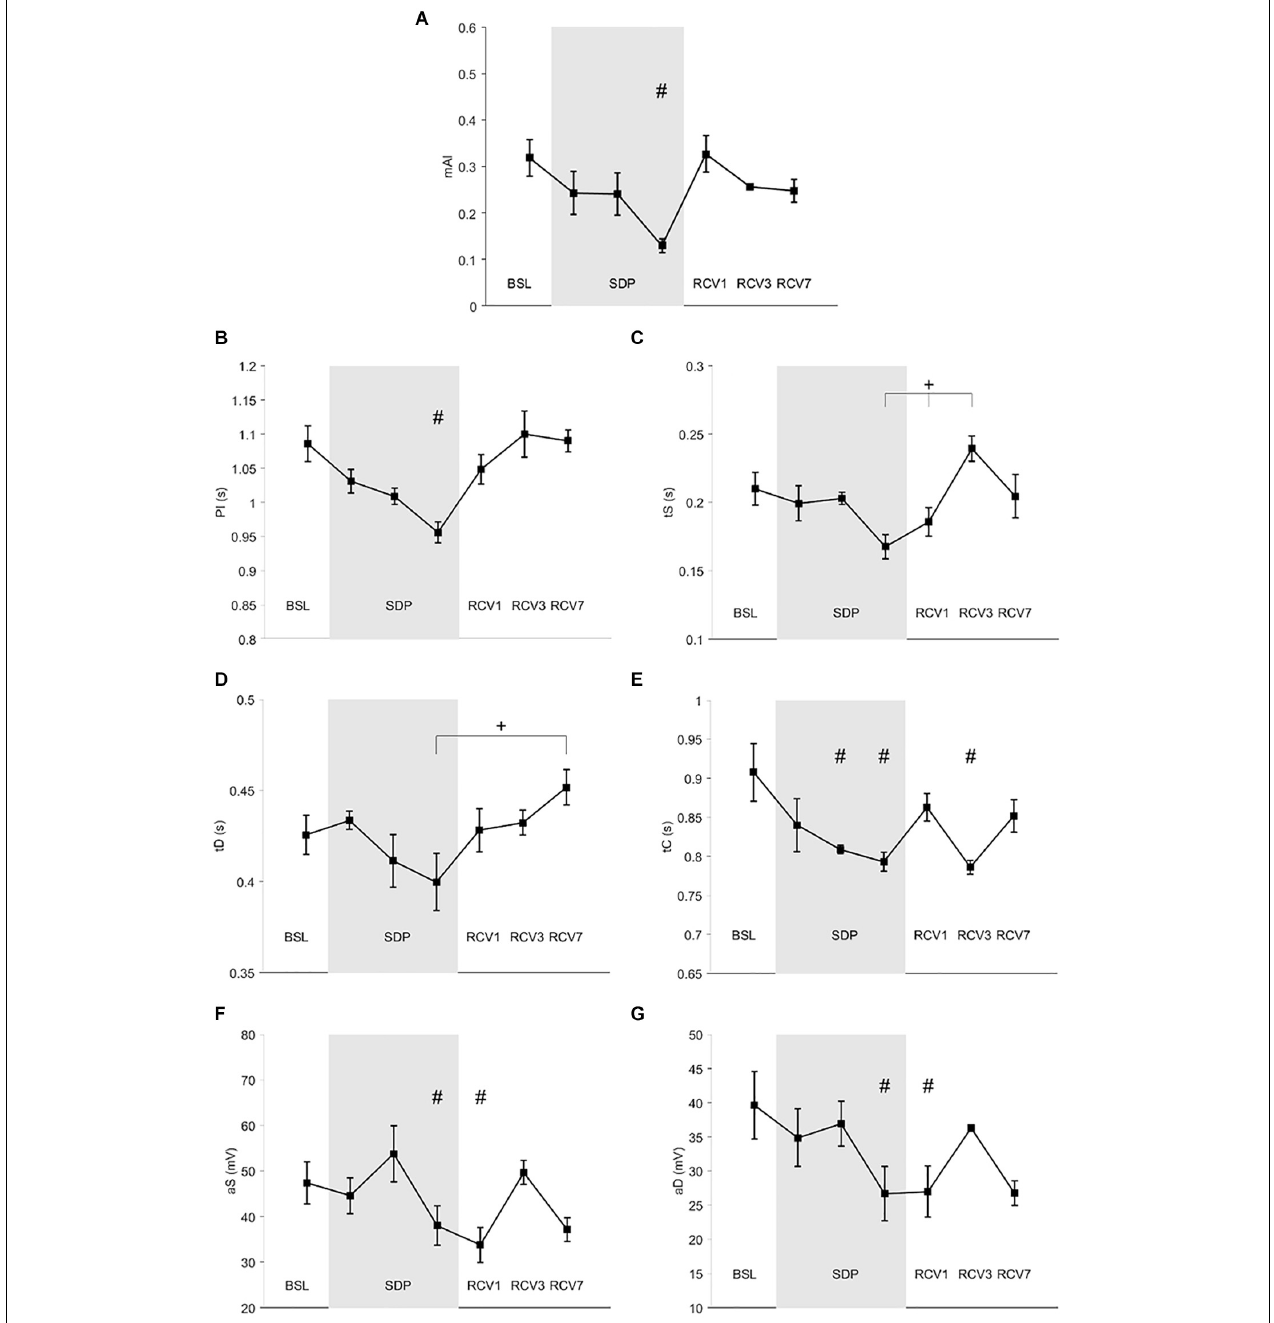
FIGURE 3 | Photoplethysmography (PPG) parameters during baseline (BSL), sleep deprivation (SDP), and recovery (RCV) periods. (A) mAI, modified augmentation index; (B) PI, pulse interval; (C) tS, time of systolic wave; (D) tD, time of dicrotic wave; (E) tC, time of catacrotic wave; (F) aS, systolic amplitude; (G) aD, diastolic amplitude. # different from BSL ( p < 0 . 05), + difference between time points ( p < 0 . 05).